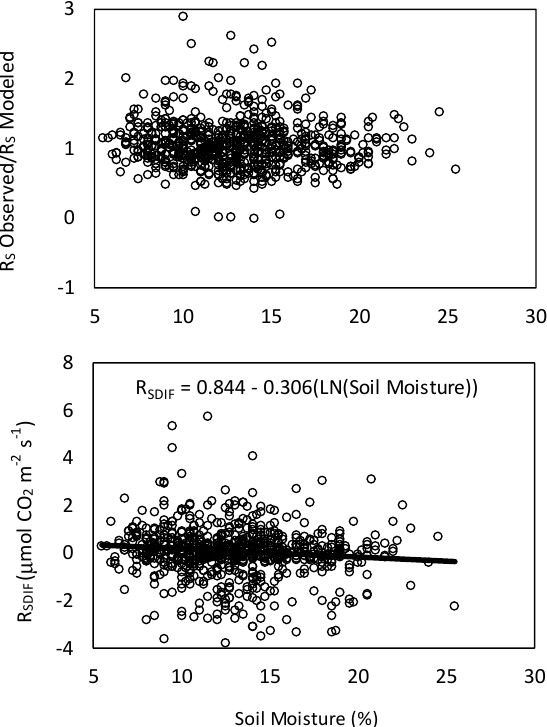
Figure 5. Relationships between two normalized estimates of soil respiration (R S ) and soil moisture in red pine stands in northern Minnesota, USA. R S Observed (top panel) indicates direct, field-based measurements of soil CO 2 efflux, and R S modeled (bottom panel) indicates estimates of soil CO 2 efflux derived from our best-fitting regression model relating R S to temperature. R SDIF was calculated as the differences between R S Observed and R S Modeled.